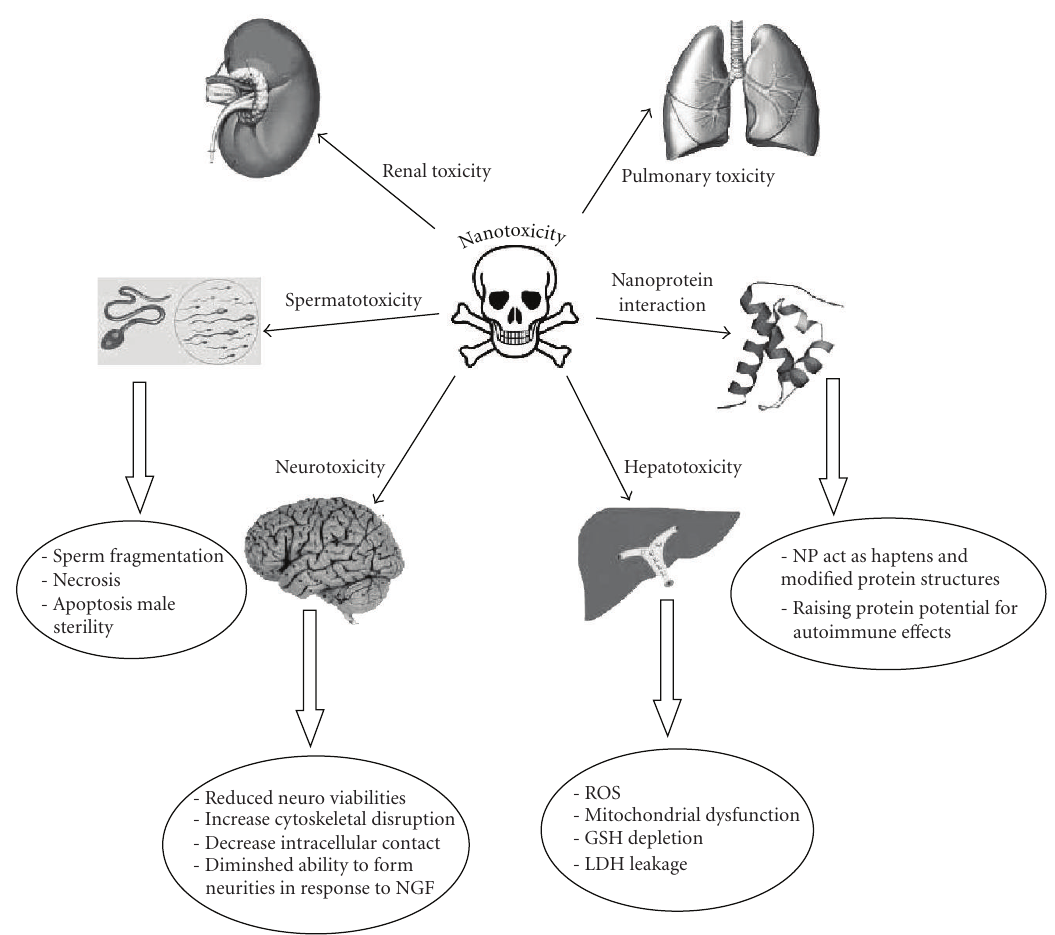
Figure 3: A summary of the most important recorded toxic e ff ects of therapeutically used nanoparticles reviewed in the present paper.